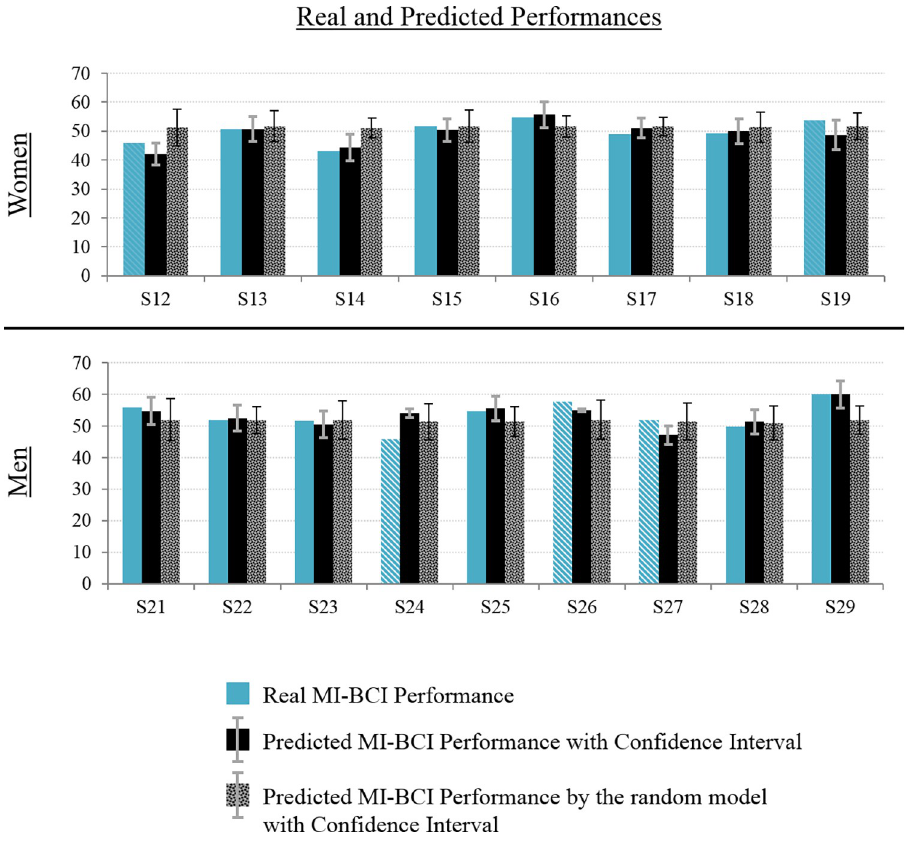
Fig 8. Real and predicted BCI performance. Women’s results are shown at the top, men’s results on bottom. We propose a graphical representation of the real (left), predicted (middle) and “chance-level predicted” (right) BCI- performance of each participant, with the corresponding confidence